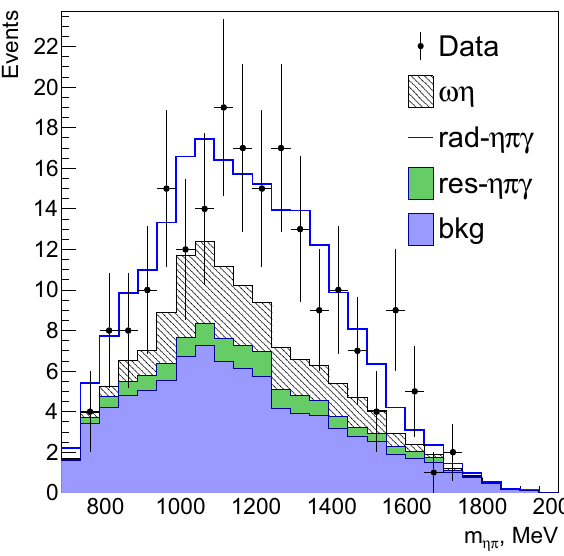
Fig. 2 The ηπ 0 invariant mass distribution for data (points with error tion for the class rad- ηπγ are calculated in the models a 0 ( 1450 )γ , √ a 2 ( 1320 )γ , and a 0 ( 980 )γ , respectively. Right panel: The contributions s = 1 . 05–2.00 GeV. Events from the ω meson bars) from the interval peak (700 < m πγ < 900 MeV) are rejected. Left panel: The shaded of the four classes of events are shown cumulatively. The distribution for the class rad- ηπγ is obtained from the fit to the two-dimensional histogram shows the total distribution for the background and the pro- distribution of m πγ versus m ηπ as described in the cesses (7) and (8). The solid, dotted and dashed histograms show the total distribution for events of all four classes, in which the distribu-